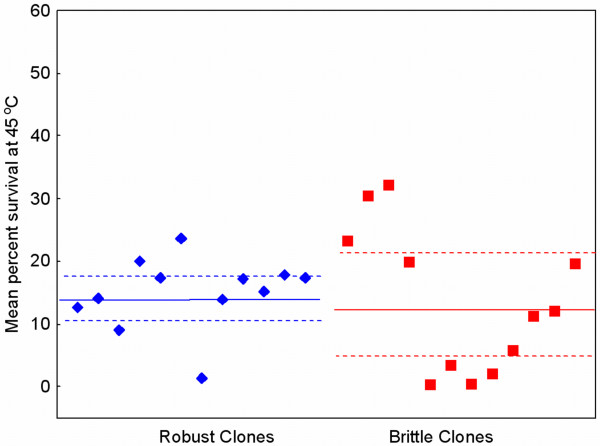
Initial percent survival after heat shock (45°C) does not differ for 12 robust virus clones (diamonds), and 12 brittle virus clones (squares). Solid line is the grand mean for the group, and dashed lines are 95% confidence intervals.